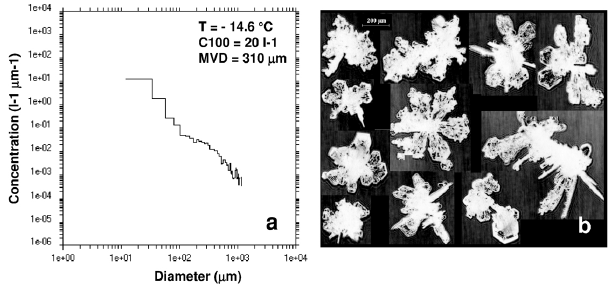
Fig. 10. (a) Particle size distribution measured by the CPI during the sequence between 10:58 and 11:06UTC on Fig. 1 ( T = − 14.6 ◦ C). (b) : Examples of ice crystal images measured by the CPI during this